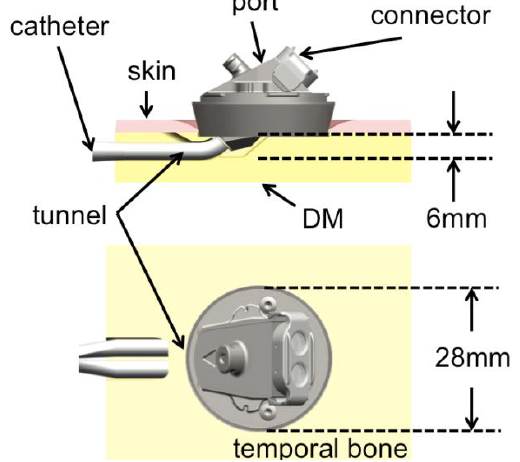
Figure 1. Schema of the implanted dialysis port, longitudinal section and view from above. A small tunnel is drilled in the bone to stabilize the skin surrounding the port. DM: Dura Mater